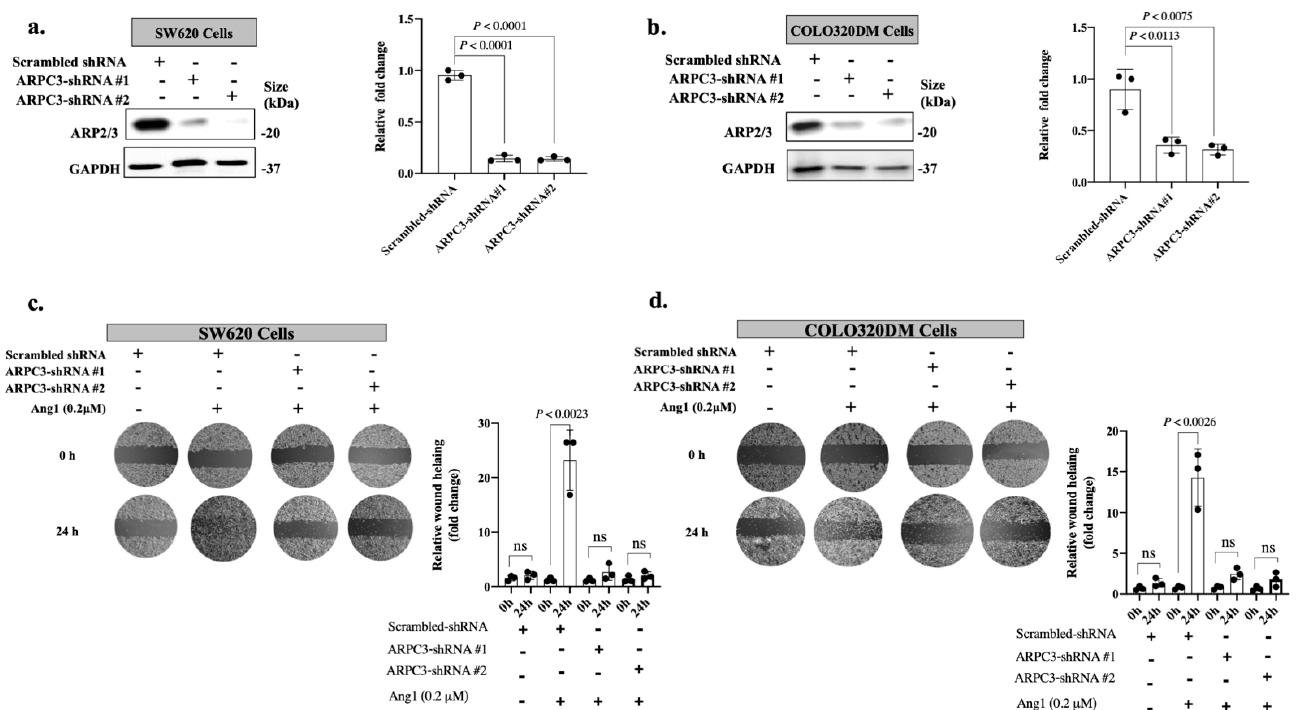
Figure 3. ARP2/3 mediates Ang1-driven cancer cell motility. ( a , b ) Western blotting of ARP2/3 expression in SW620 or COLO320dm cancer cells expressing shRNA-scrambled or shRNA-ARPC3. The right panels show the intensity of ARP2/3 bands that were quantified and normalized against GAPDH using ImageJ and represented as a fold change (n = 3). ( c , d ) Representative scratch assay in SW620 or COLO320dm cells expressing shRNA-scrambled or shRNA-ARPC3 upon exposure to Ang1. The right panels show the corresponding wound healing ratio shown in fold change (n = 3). Data are presented as the mean ± SD. ns = Not significant.